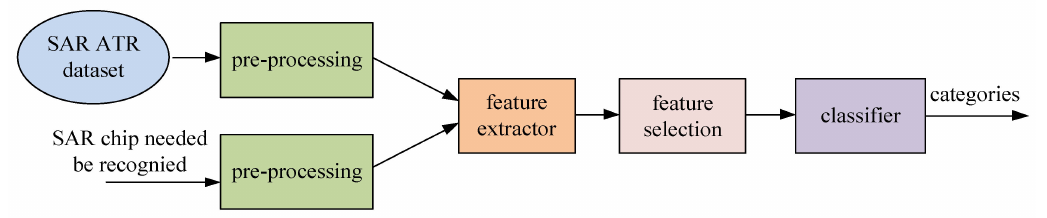
Figure 7. The process of machine-learning-based SAR ATR